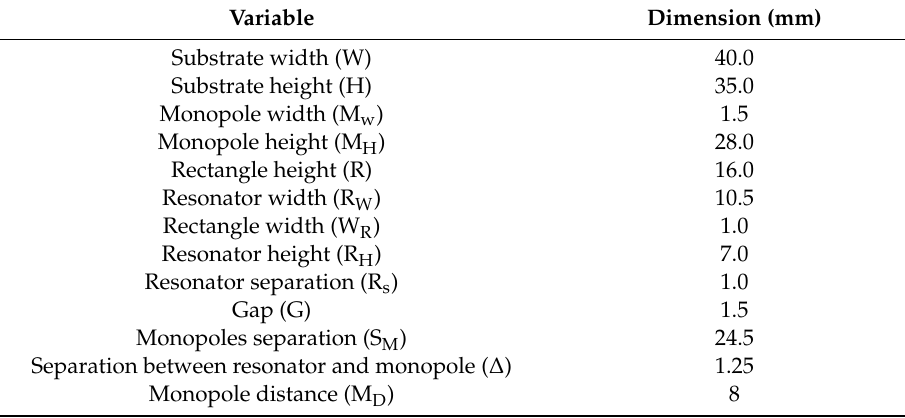
Table 1. Dimensions of the proposed sensor based on a monopole-coupled